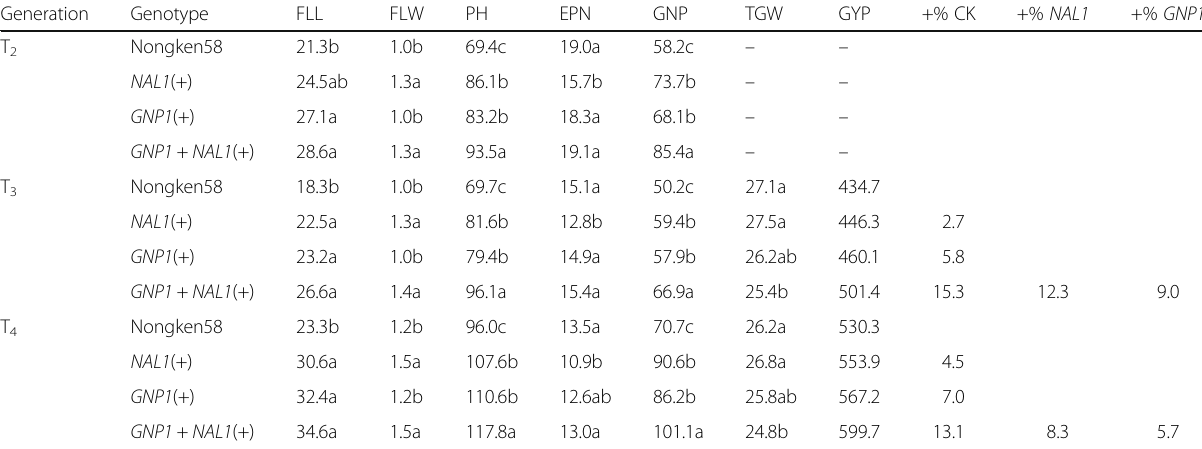
Table 4 Performance of three homozygous transgenic lines under nature conditions